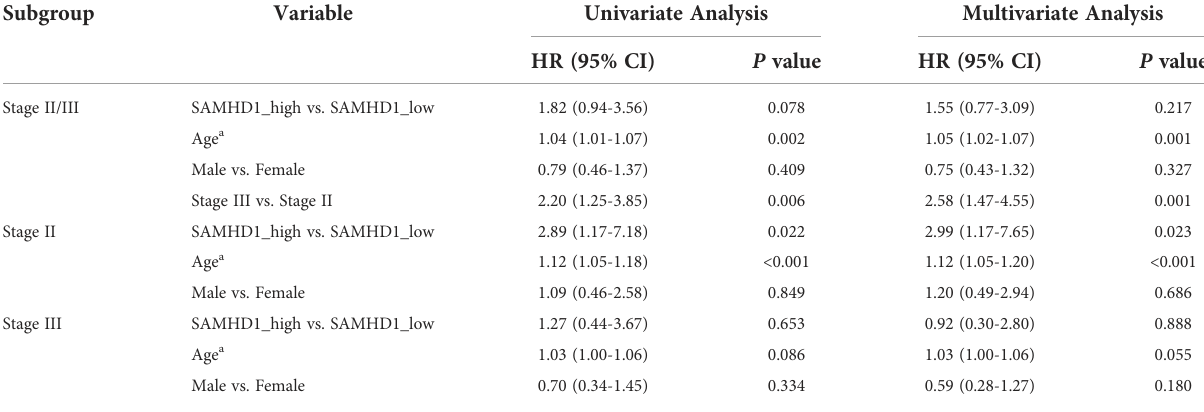
TABLE 1 Univariate and multivariable Cox analyses for overall survival among patients in the discovery data set.